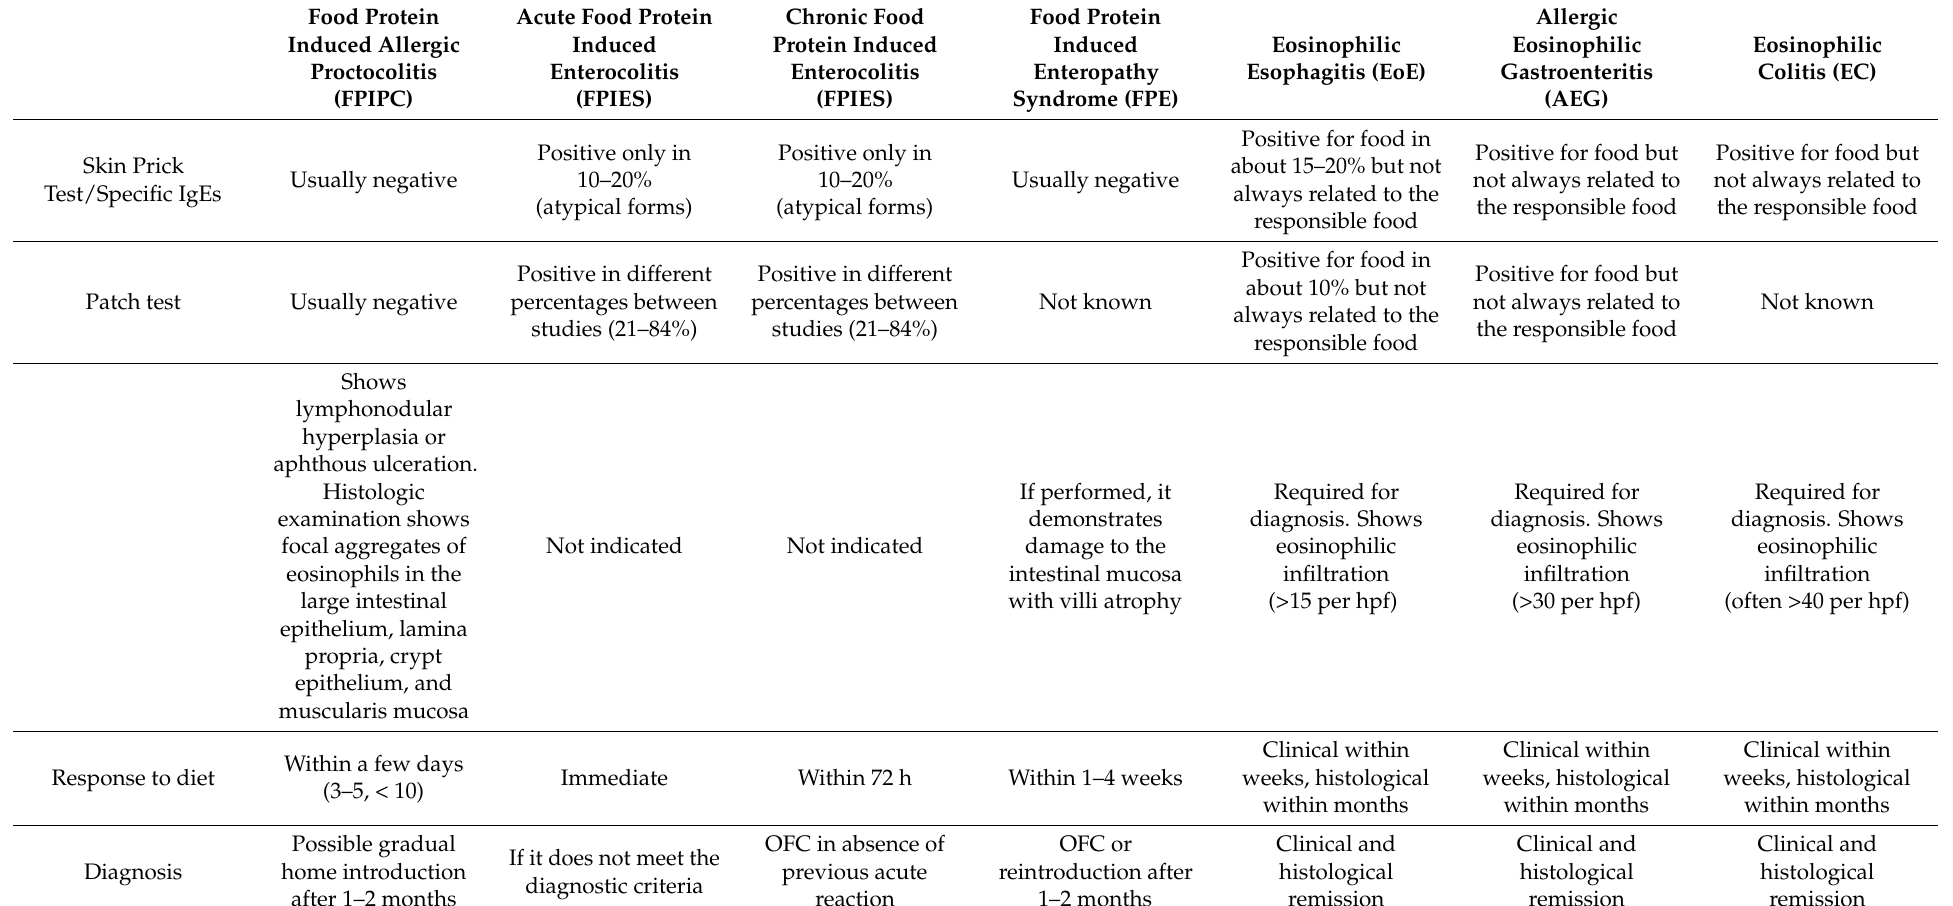
Table 2. Diagnostic tools for Non–IgE- or Mixed IgE/non–IgE-mediated Gastrointestinal Food